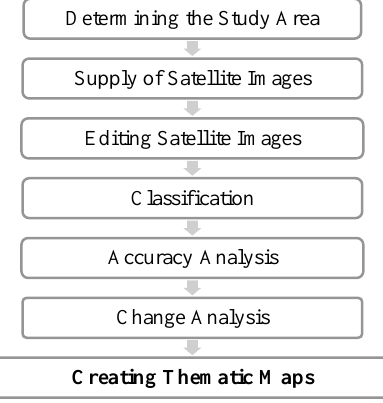
Figure 3. Work-Flow